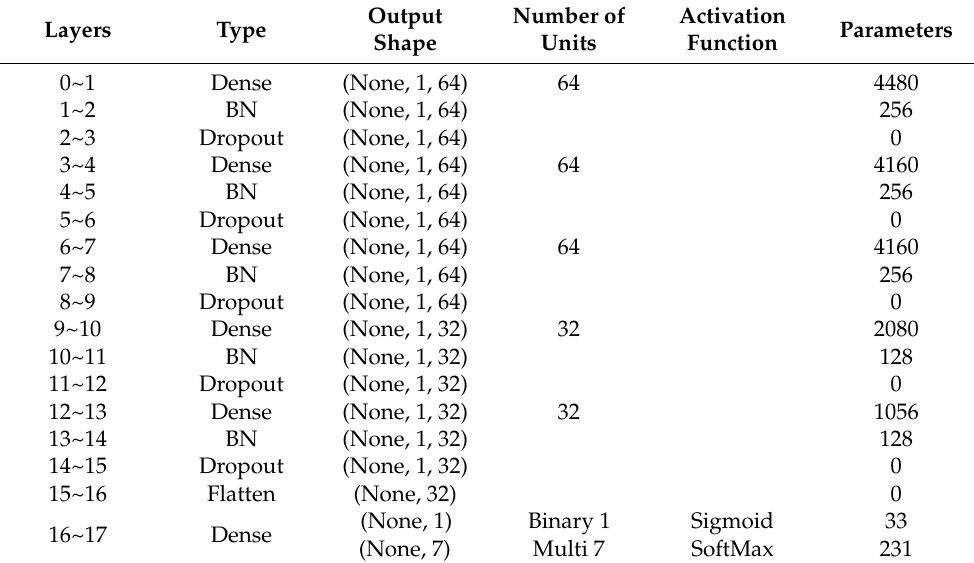
Table 7. DNN-5-256 (5 layers and 256